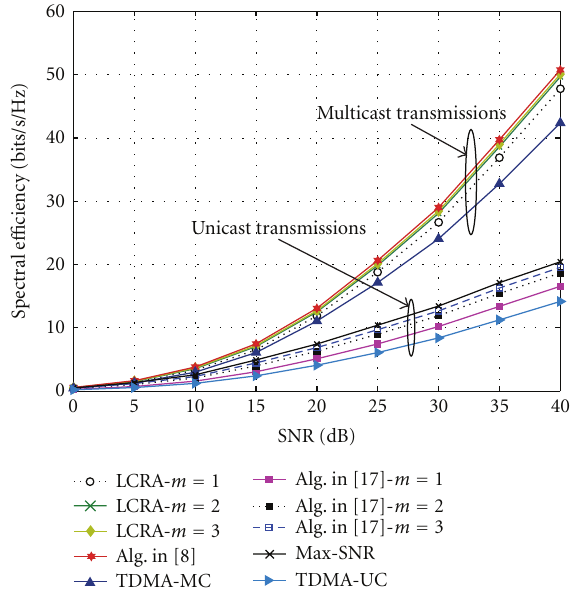
Figure 5: Spectral e ffi ciency versus average BER.